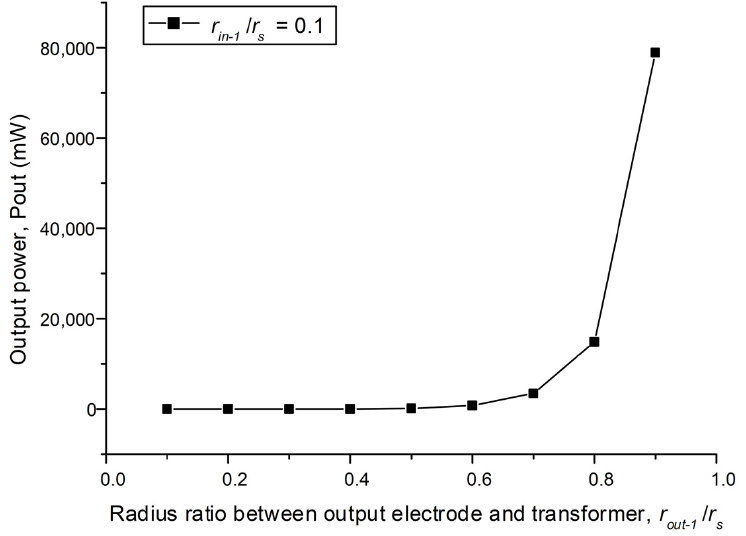
Figure 9. The optimal output powers corresponding to different radius of output electrodes.